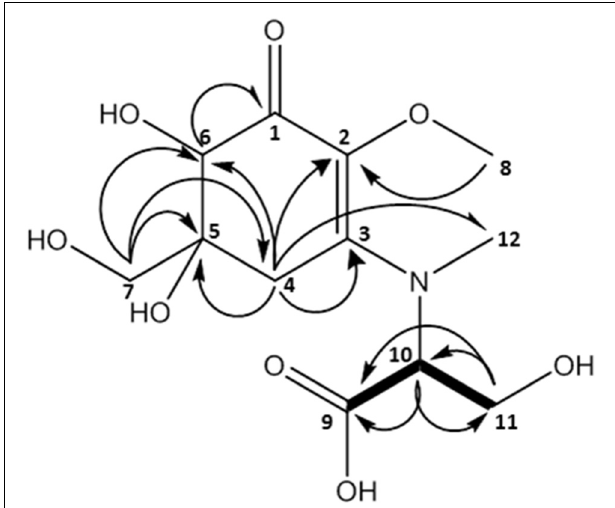
FIGURE 4 | MAA compound 2 (klebsormidin B) isolated from extracts of Klebsormidium crenulatum was assigned to the molecular formula C 12 H 19 NO 8 as established by a positive [M + H] + ion at 306.1160.